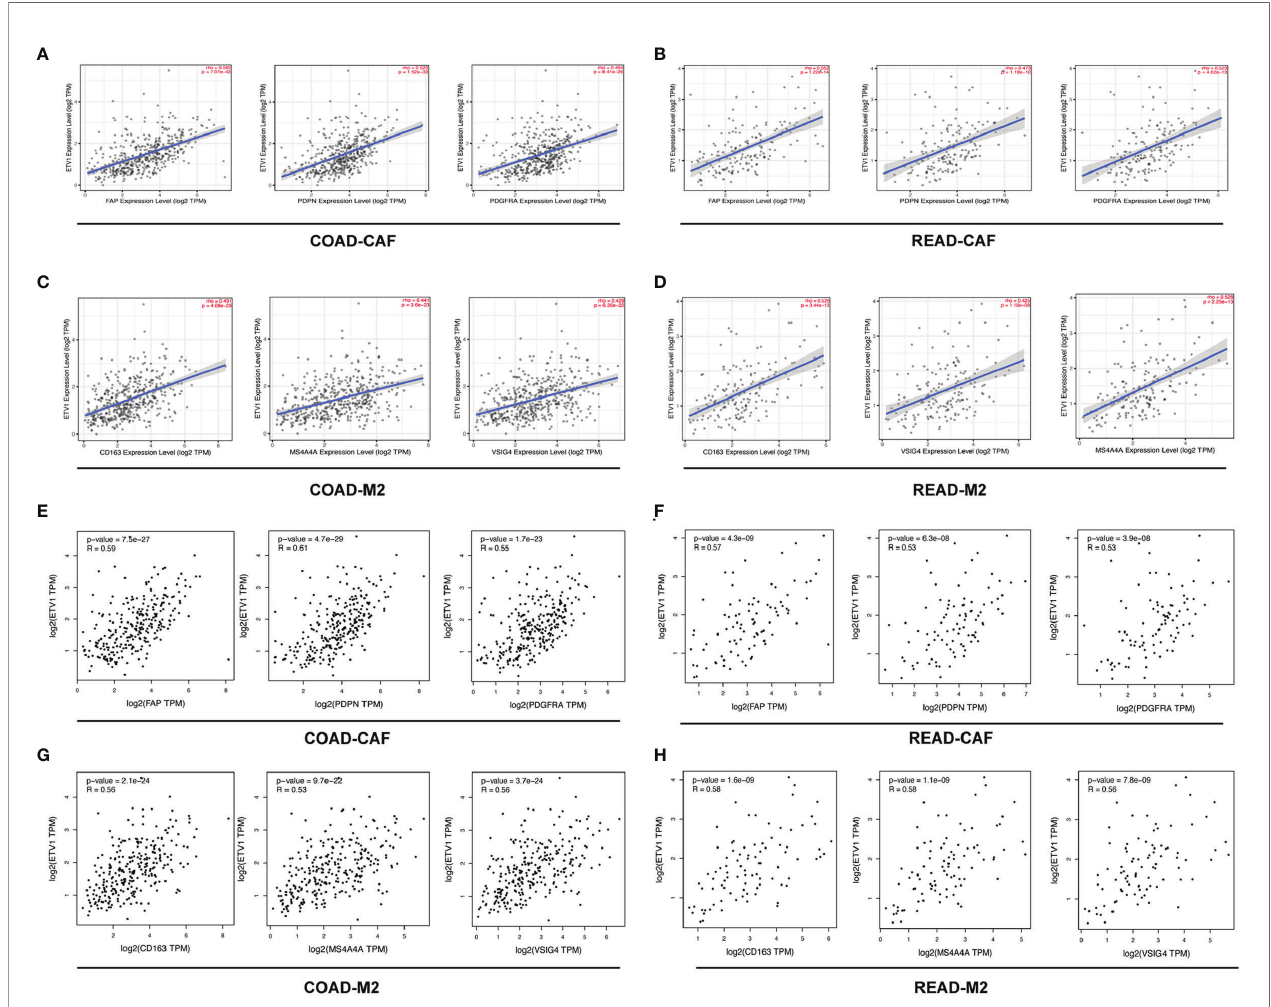
FIGURE 4 | The correlation among the expression level of ETV1 and M2 macrophages and cancer associated fi broblast (CAFs) in CRC from TIMER and GEPIA. (A – D) Scatterplots of correlations between ETV1 expression and gene markers of CAFs and M2 macrophages in CRC from TIMER. (E – H) Scatterplots of correlations between ETV1 expression and gene markers of CAFs and M2 macrophages in CRC from